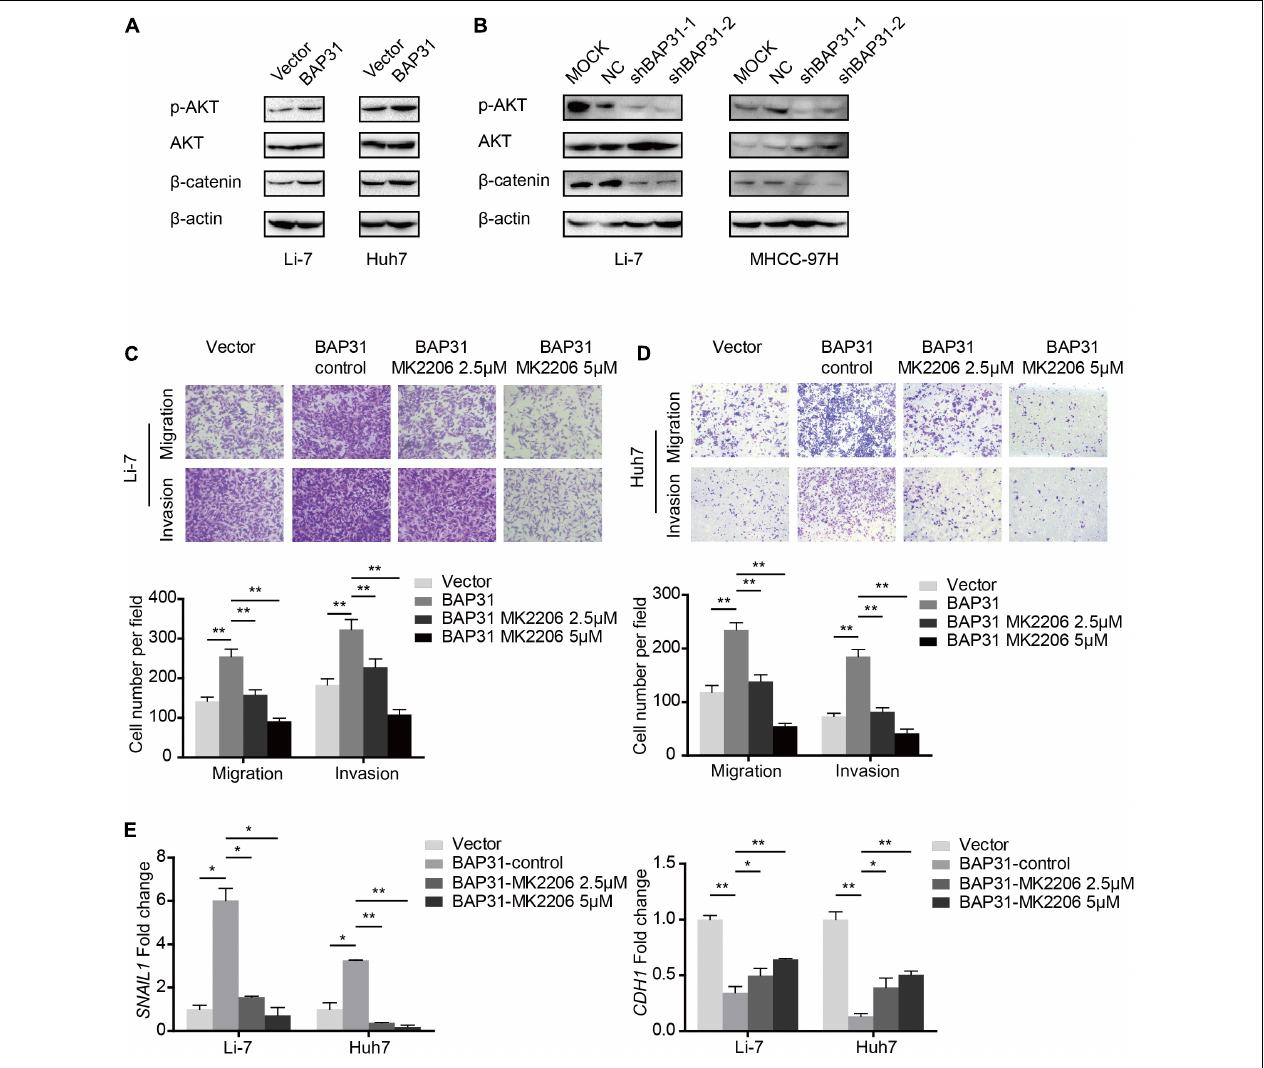
FIGURE 5 | BAP31 promoted HCC progression via AKT/ β -catenin/Snail pathway. (A,B) Western blot analysis showing protein expression of phosphorylated AKT, pan-AKT, β -catenin and BAP31 in HCC cells with overexpression and knockdown of BAP31. (C,D) Transwell assay analysis of the migratory and invasive abilities in Li-7 and Huh7 cells, which were divided into four groups: vector, BAP31 (DMSO-control), BAP31 (MK2206 2.5 µ M) and BAP31 (MK2206 5 µ M). (E) Fold change of Snail ( SNAIL1 ) and E-cadherin ( CDH1 ) mRNA expression in Li-7 and Huh7 cell, which were divided into four groups: vector, BAP31 (DMSO-control), BAP31 (MK2206 2.5 µ M) and BAP31 (MK2206 5 µ M). Results were presented as mean ± SD and t -test was conducted between vector and BAP31 (DMSO-control), BAP31 (DMSO-control) and BAP31 (MK2206 2.5 µ M/5 µ M) group ( n = 3, * p < 0.05, ** p <